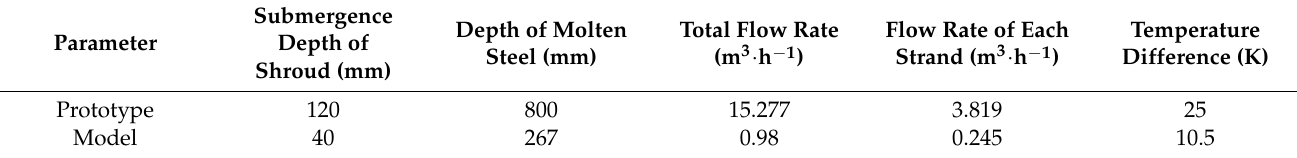
Table 1. Parameters of the tundish in the prototype and the model.